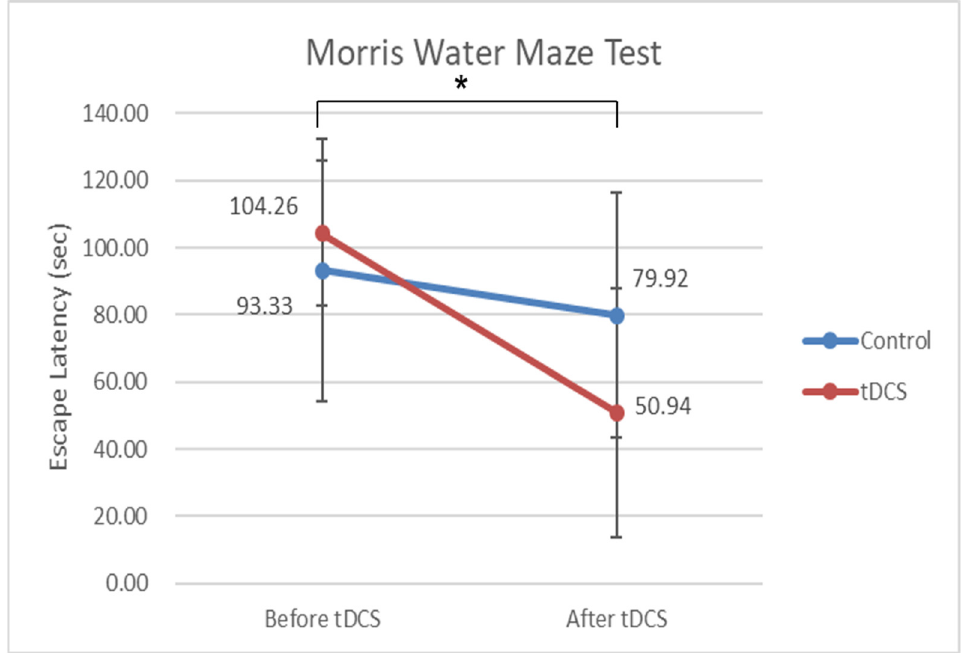
Figure 3. Escape latency on the hidden platform trial on the Morris-water maze (MWM) test. The